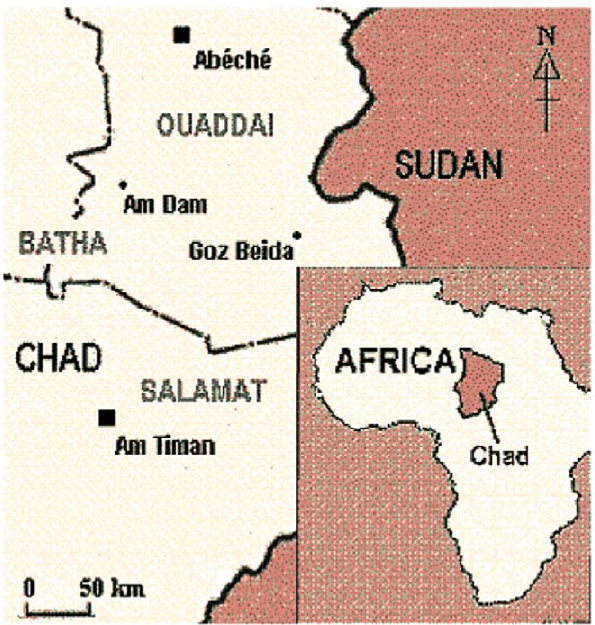
Figure 1. Location of Goz Beida, Am Dam and Am Timan in Eastern